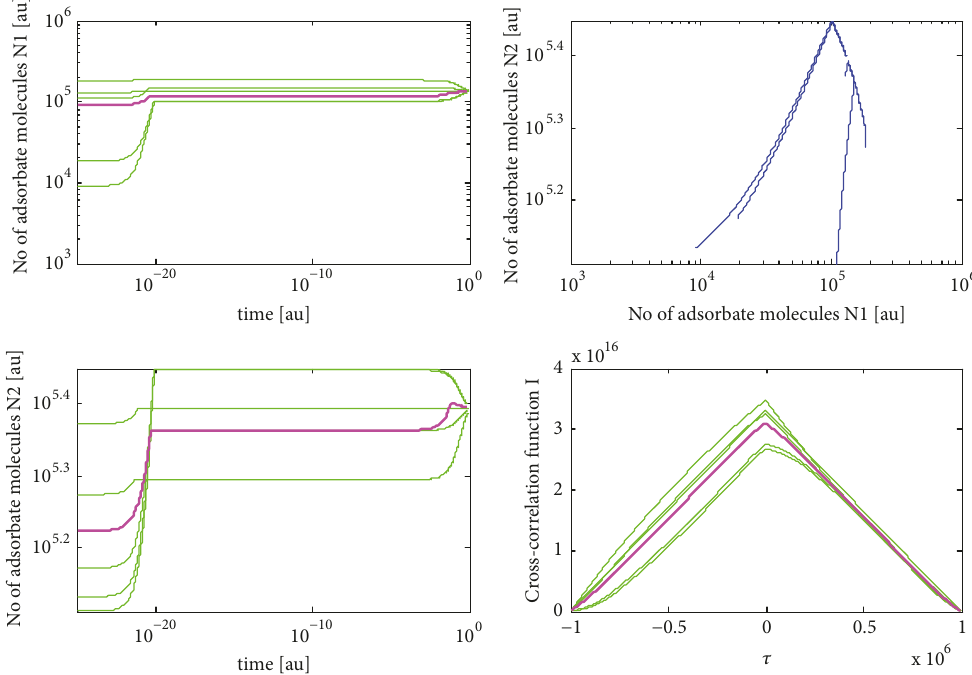
Figure 3: Time evolutions of the number of adsorbed molecules (left), phase space (up right), and the corresponding cross-correlation function (down right), fictive mixture, random initial moment.